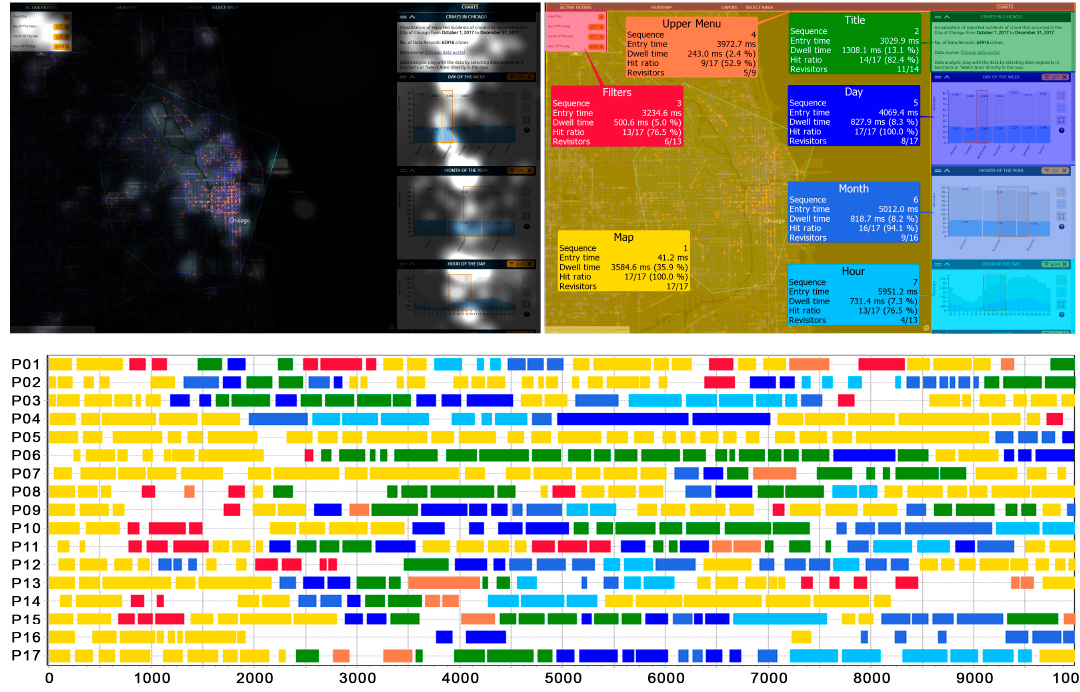
Figure 5. Analysis of recorded data for static stimulus of Chicago map. Focus map ( upper left ), key performance indicators ( upper right ), and sequence chart ( bottom ).